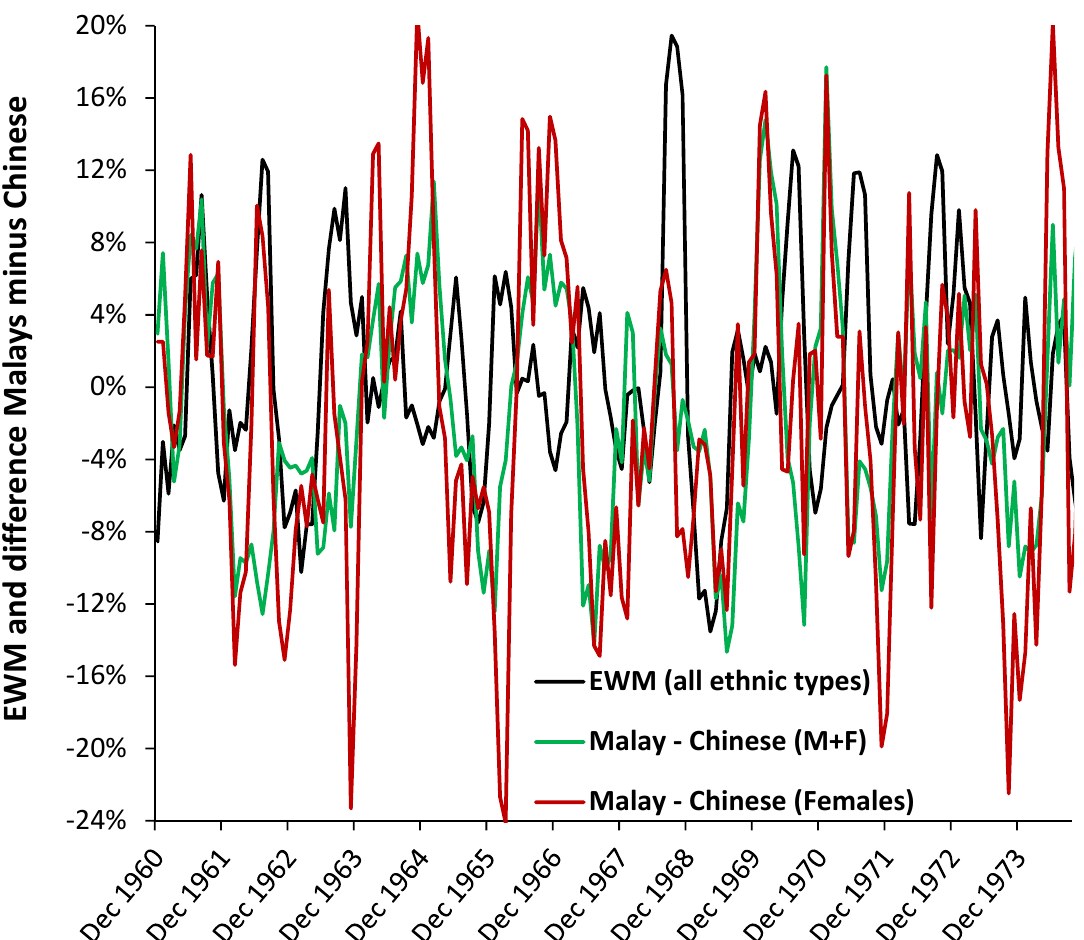
Figure 6. Difference in EWM between Malays and Chinese in Singapore (1960 to 1974).